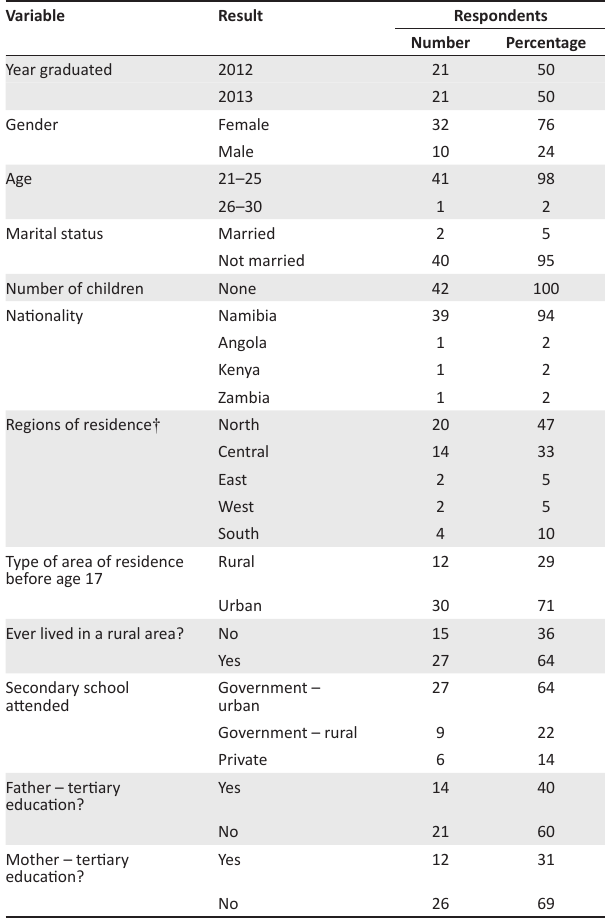
TABLE 1: Characteristics of fourth-year students in the Biomedical Science programme at the Polytechnic of Namibia in 2011 and 2012.